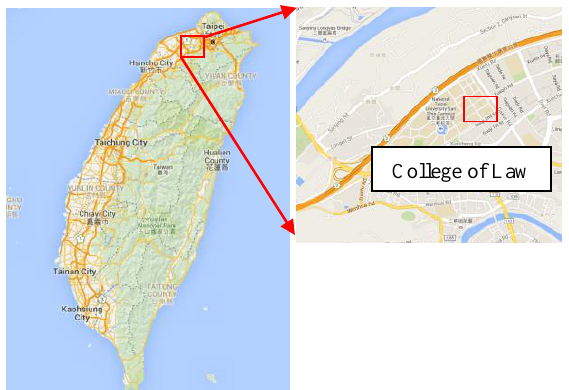
Figure 1. Location of the NTPU campus in Taiwan.